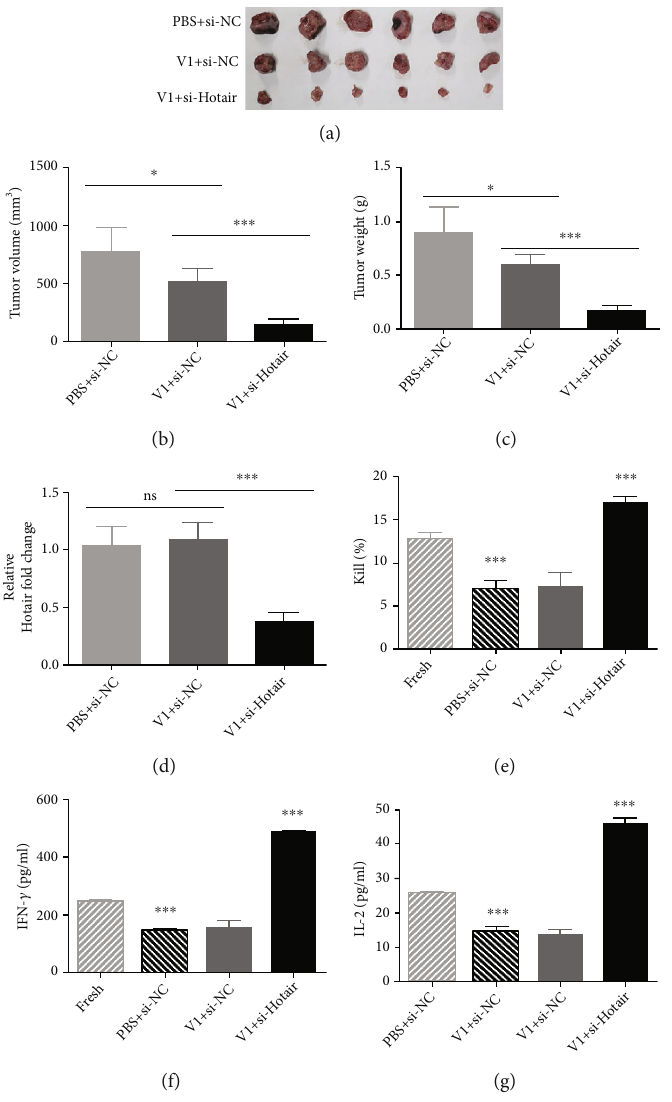
Figure 5: The combined si-Hotair and VEGF inhibitor show a better antitumor function in vivo. (a – d) The representative image showed subcutaneous tumors in CD34+ hu-NSG ™ mice injected with PBS plus cholesterol-coupled si-NC, or V1 plus cholesterol-coupled si-NC, or V1 plus cholesterol-coupled si-Hotair. The (b) volume, (c) weight, and (d) expression levels of Hotair of subcutaneous tumors in each group were analyzed. (e) The T cell activity of PBMC cells in each group, and ELISA analyzed the concentration of cytokines (f) IFN- γ and (g) IL-2. PBMCs were collected from tail veins at two weeks after the last injection of cholesterol-coupled oligomers. Data are mean ± SD of at least three independent experiments; ∗ p < 0 : 05 ; ∗∗ p < 0 : 01 ; ∗∗∗ p < 0 : 001